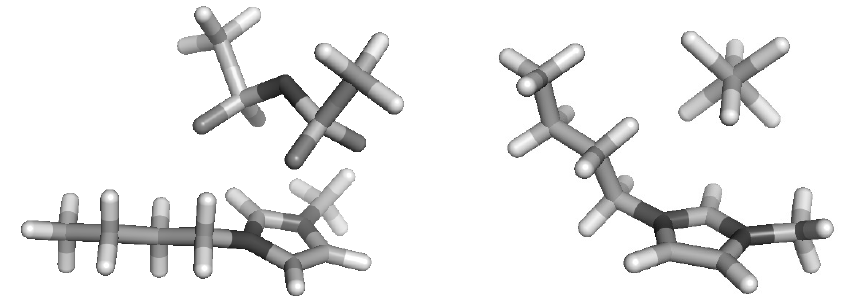
Figure 1. Pictorial view of the structures BmimNTf 2 and BmimPF 6